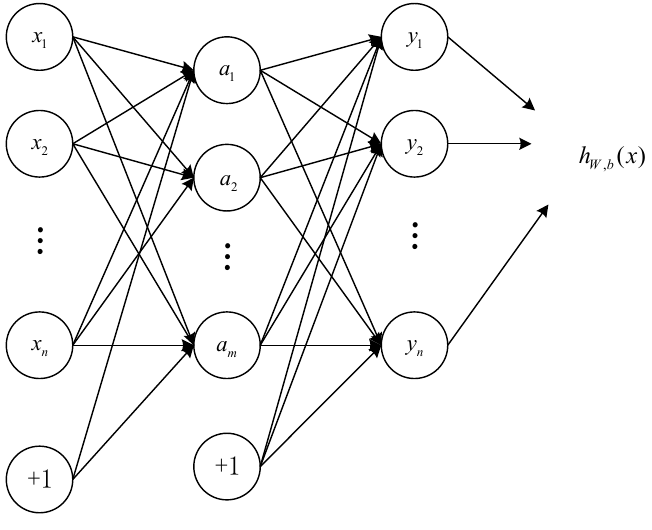
Figure 1. The architecture of auto-encoder.